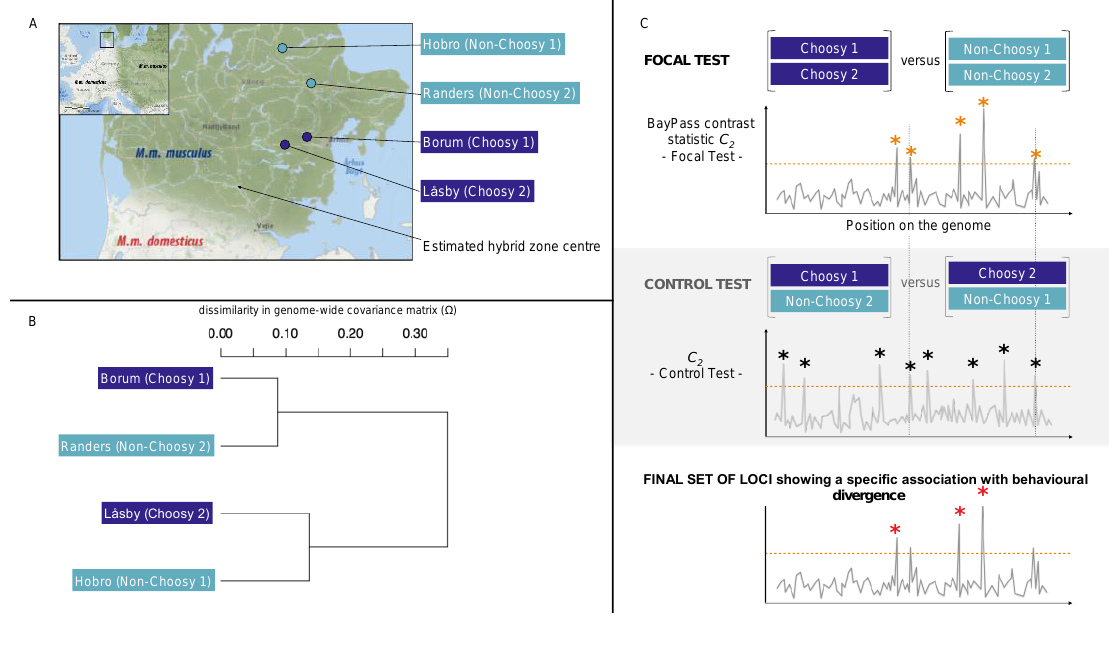
Figure 1 : Sampling and experimental design. A) Populations of Mus musculus musculus sampled in localities in the M. m. musculus - domesticus hybrid zone (dark blue points) or further away from the centre of the hybrid zone (light blue points). Mean nucleotide diversity: Låsby ( n =27, π = 0.002 +/- 1.136e-05), Borum ( n =33, π = 0.003 +/- 1.151e-05), Randers ( n =29, π = 0.002 +/- 1.027e-05), Hobro ( n